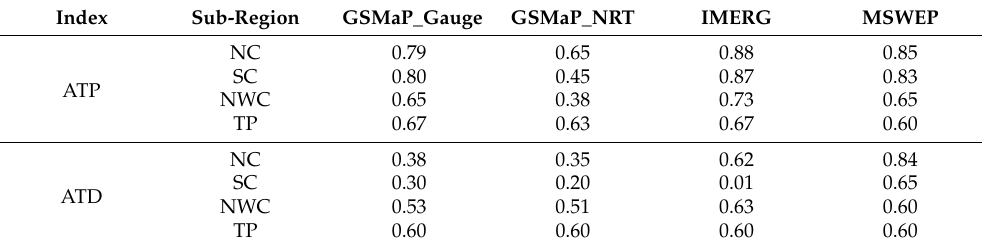
Figure 5. The LISA cluster maps of ATD between the gauge observations and the four SPPs and the number in the bracket represent the corresponding number of gauges: ( a ) GSMaP_Gauge, ( b ) GSMaP_NRT, ( c ) IMERG, and ( d ) MSWEP. Table 3. The global BMI of total indices in four